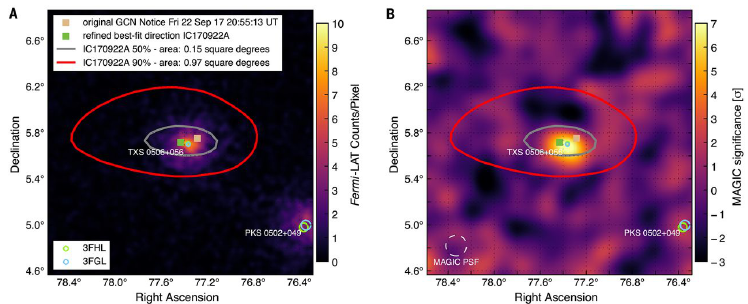
Figure 2. Sky map of IceCube-170922A in J2000 equatorial declination and right ascension. Both panels include the direction uncertainty regions corresponding to 50% and 90% containment. Also Figure 1. IceCube-160427A, the first real time neutrino alert sent by IceCube, on April 27, 2016. It is a shown on both panels is the known location of the blazar TXS 0506 + 056. The left plot (A) overlays starting ν µ event. Here DOMs are indicated as dots. Colored spheres are DOMs reporting signals, with Fermi data accumulated over 9.5 years. The right plot (B) overlays MAGIC data above 100 GeV in this red being early and blue, being late. The red arrow indicates the best reconstructed track hypothesis.